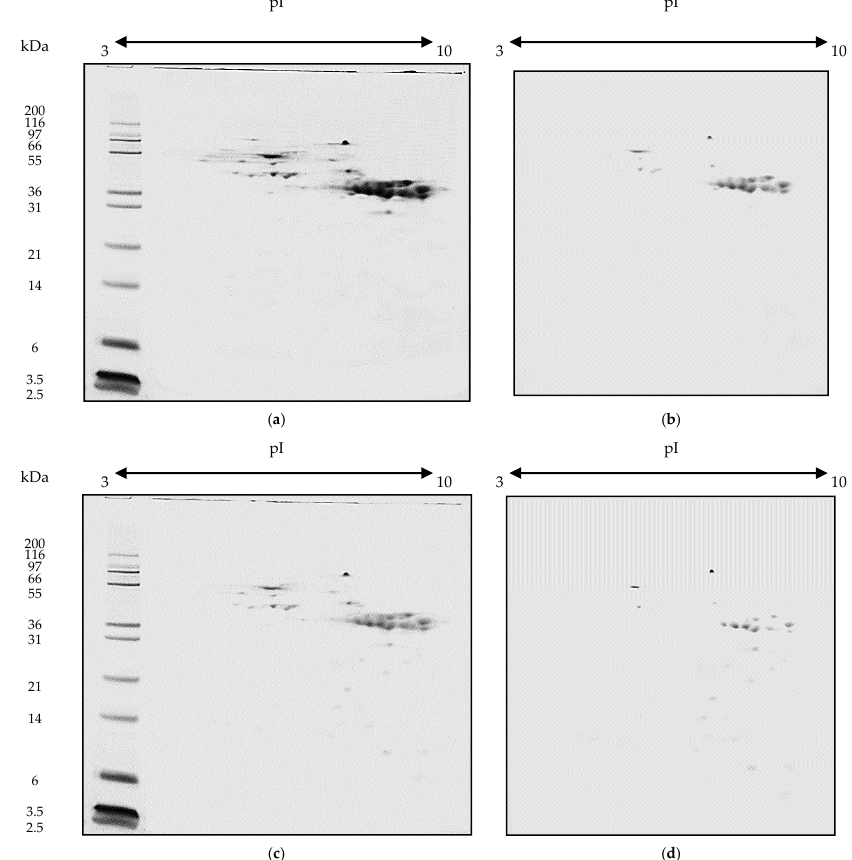
Figure 1. Electropherograms 2D NuPAGE of native gliadins ( a ) and gliadins hydrolysed by a mixture of peptidases from L. acidophilus 5e2 and A. niger ( c ) and immunoblots of native ( b ) and hydrolysed gliadins ( d ). Reaction conditions: pH 4, 37 °C, 3